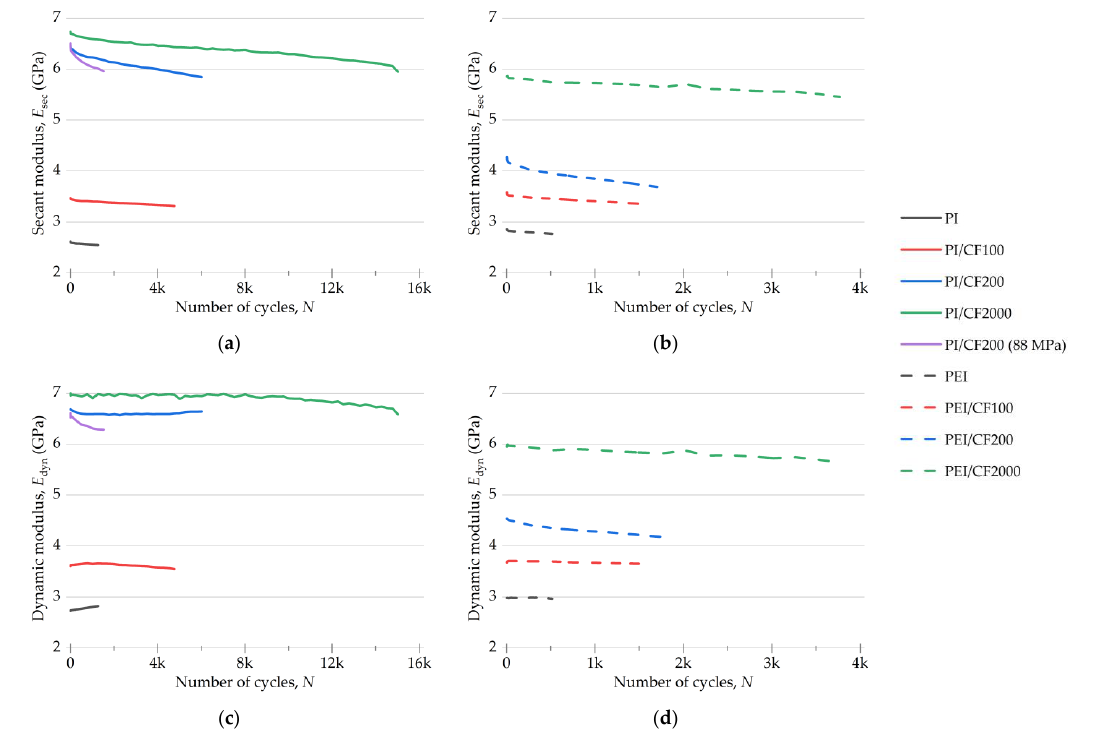
Figure 8. The changes in E sec secant ( a , b ) and E dyn dynamic ( c , d ) moduli for the PI- and PEI-based composites under cyclic loads.